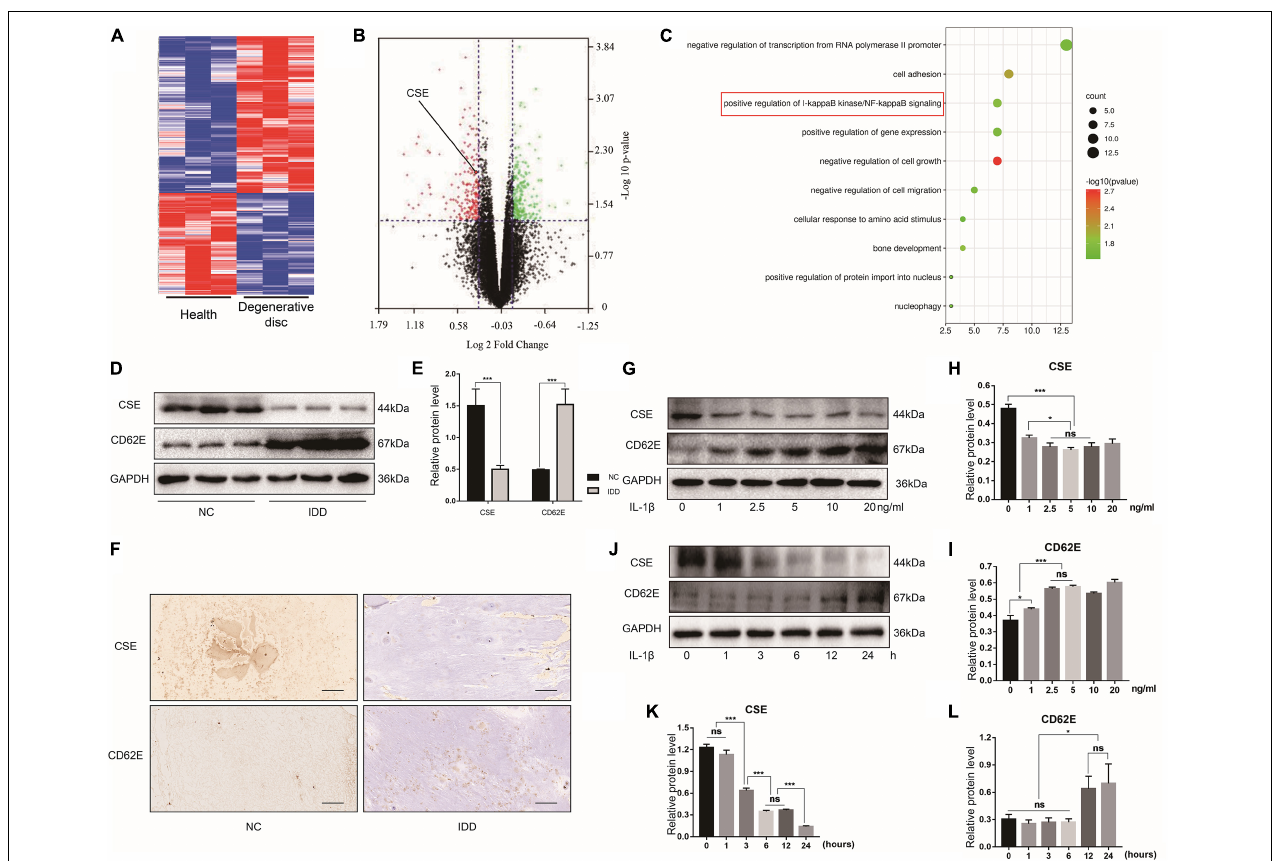
FIGURE 1 | Cystathionine- γ -lyase and CD62E expression in NP tissues and cells. Bioinformatics analysis of expression profiles of patients with IDD and adolescent idiopathic scoliosis. (A) Heat map of top 300 DEGs. (B) Volcano plot of DEGs shows significantly altered mRNA expression with p < 0.05 (green dots: upregulated DEGs; red dots: downregulated DEGs). (C) GO analysis term. (D) Western blot images of CSE and CD62E and (E) its quantitative analysis. (F) IHC images of NP tissue (CSE and CD62E). (G) Representative western blot images of NP cells after stimulation with various doses of IL-1 β for 24 h and (H,I) its quantitative analysis. (J) Representative western blot images of NP cells after stimulation with 5 ng/mL IL-1 β for different times and (K,L) its quantitative analysis. Black scale bar: 100 µ